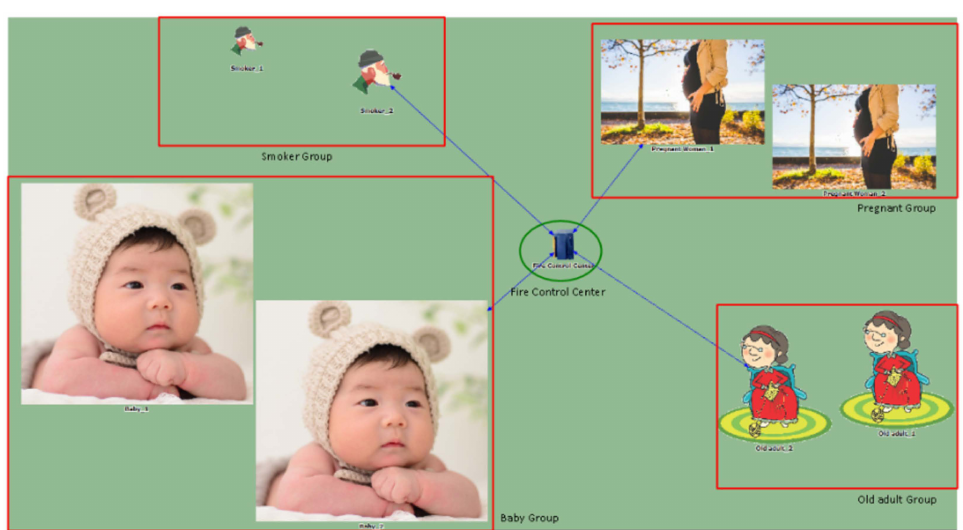
Figure 14. Network configuration map for reinforcing safety education for fire prevention.